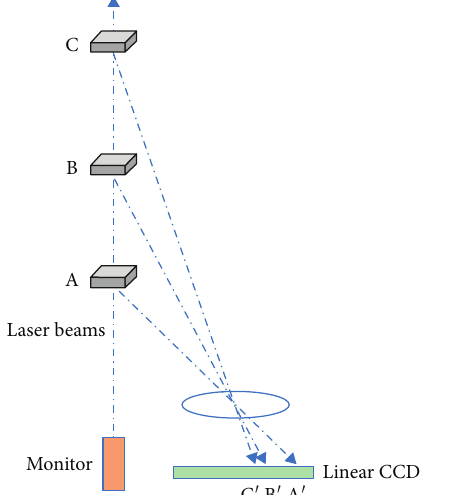
Figure 4: Principle diagram of laser monitoring of denudation